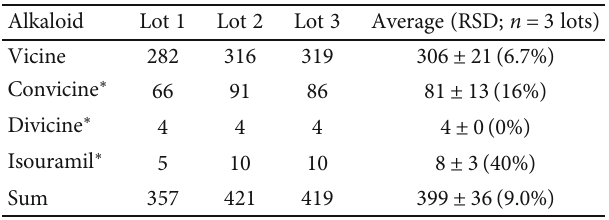
Table 2: Pyrimidine concentrations, as mg/kg, in a commercial fava bean protein